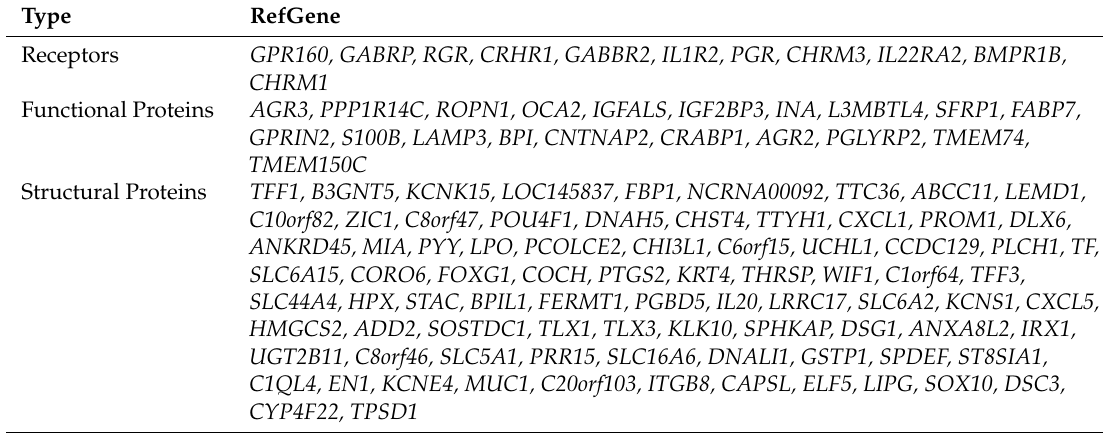
Table 2. Allocated categories of 114 di ff erentially methylated and expressed genes (DMEGs) for triple-negative breast cancer